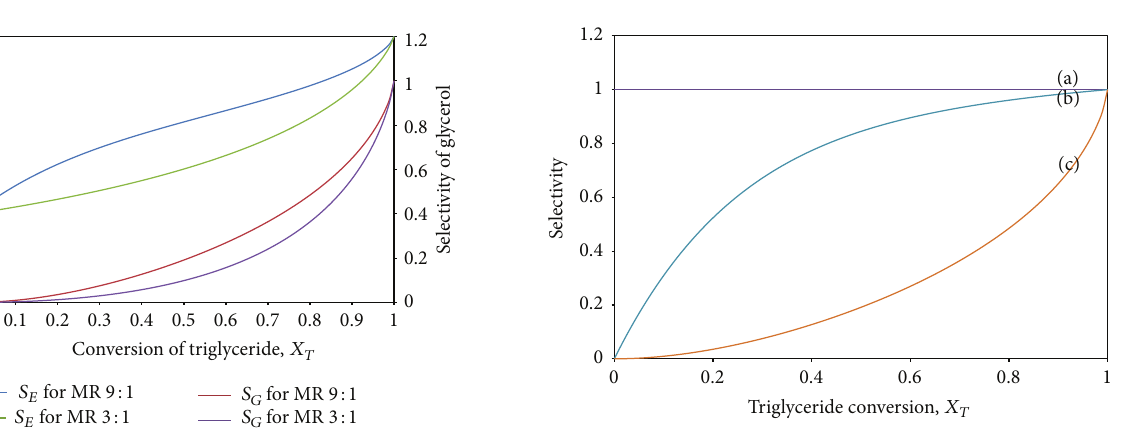
Figure 5: Selectivity of methyl ester at various molar ratios, constant temperature of 65 ∘ C, and catalyst concentration of 1.5wt.% for Case 1.